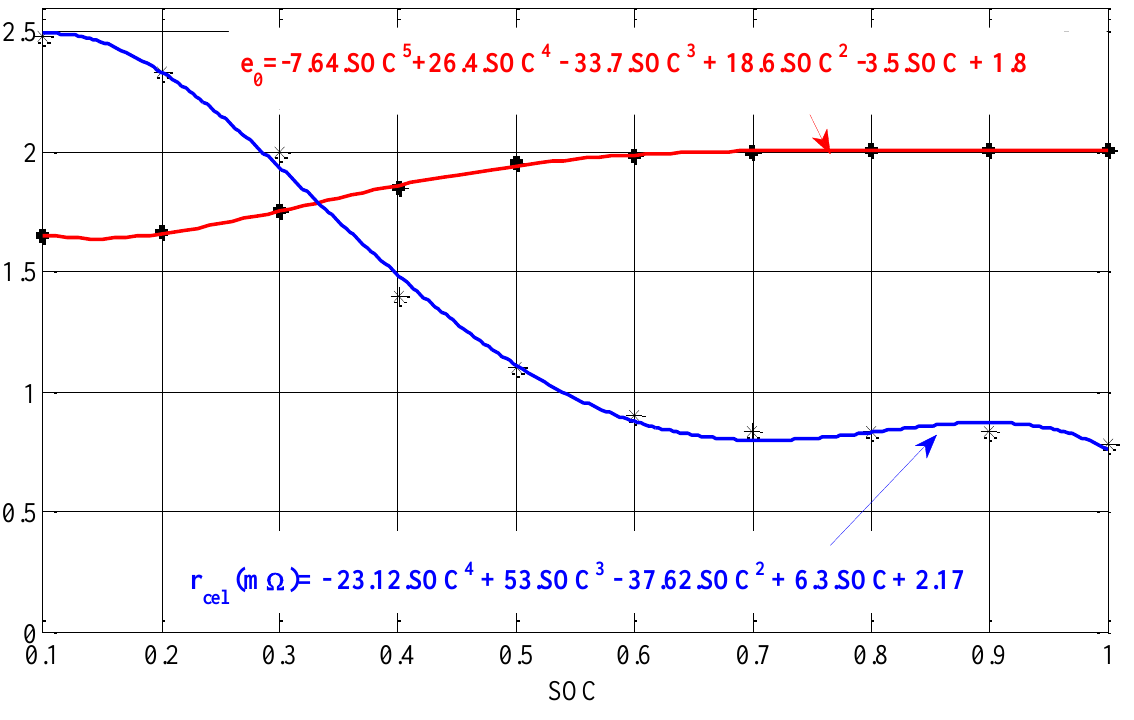
Figure 12. Evolution of rcel and e 0 as a function of the state of charge of a cell [35]. Factors Influencing the Aging of the Battery